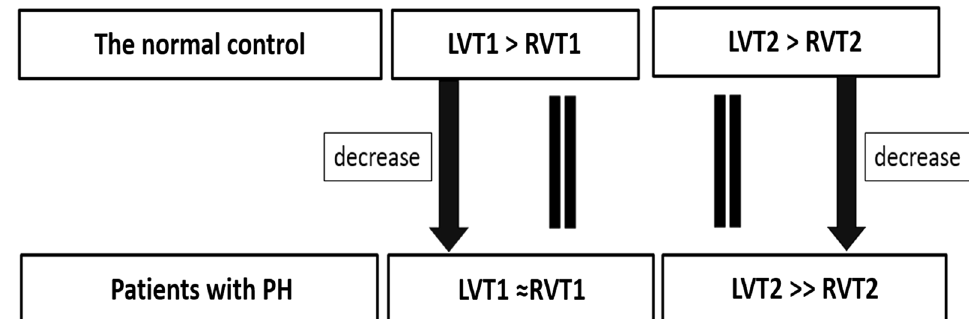
PH Pulmonary hypertension, RV Right ventricular, LV Left ventricular * p < 0.001 =